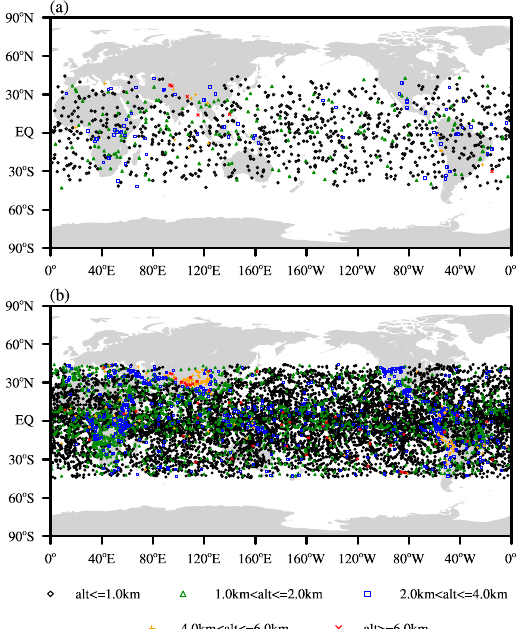
Figure 2. The characteristics of the spatial distribution for the C2E1 RO observation location. ( a ) C2E1 RO data on 20220208, ( b ) same as ( a ) but for the period of 8 February 2022 to 17 February 2022.